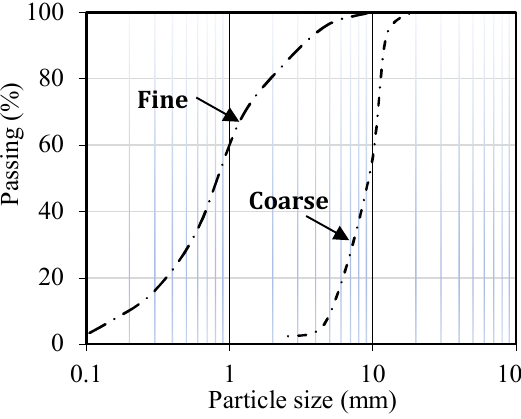
Figure 2. Particle size distributions of the fine and coarse aggregates.